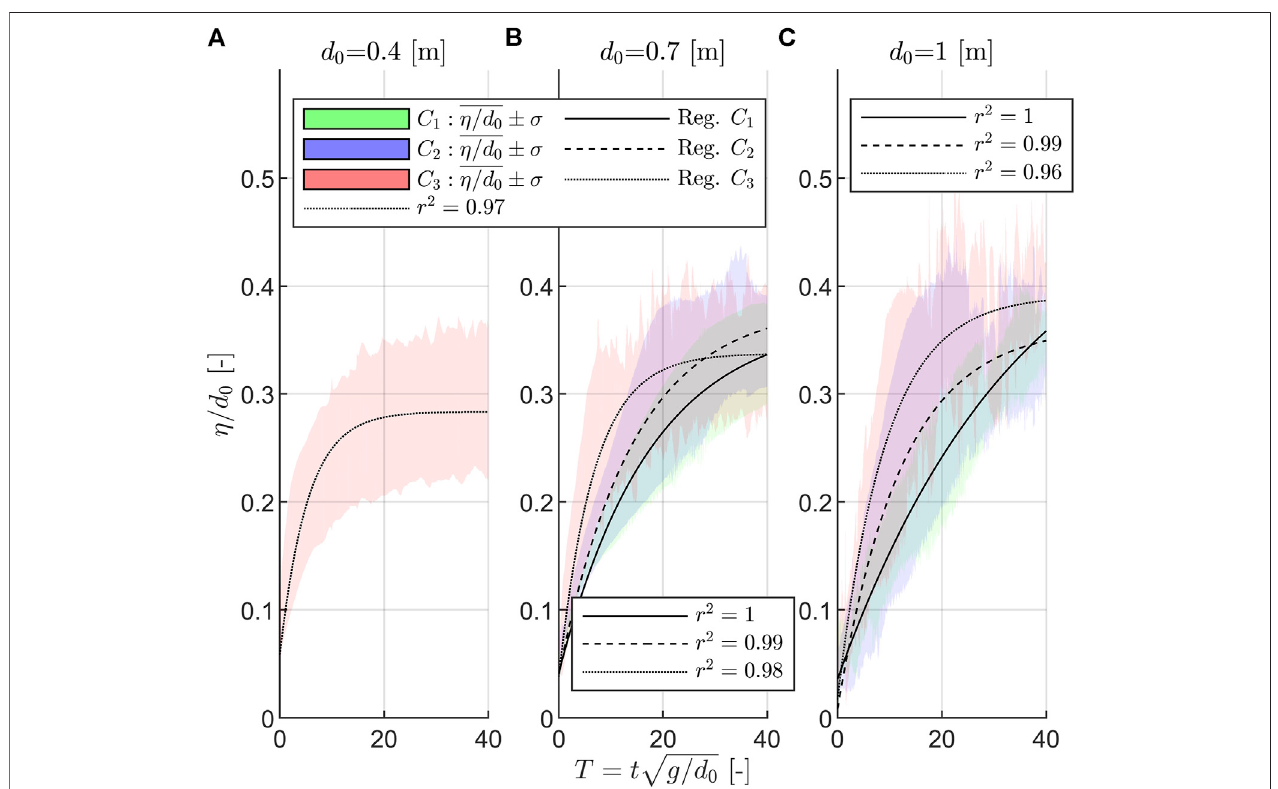
FIGURE 9 | Class-averaged normalized surface elevation time history ( η / d 0 , on the ordinate) separated by classes (C1 – C3) at the transition point ( x (cid:1) 0 m ) over (cid:4)(cid:4)(cid:4)(cid:4)(cid:4) (cid:7) g / d 0 dimensionless time ( T (cid:1) t ) and separated by initial impoundment depth (A – C) . Colored areas represent class-averaged surface elevation time history plus-minus the standard deviation. Lines represent an approximation following Eq. 3 . Coef fi cients of determination ( r 2 ) between time histories and approximations are given.